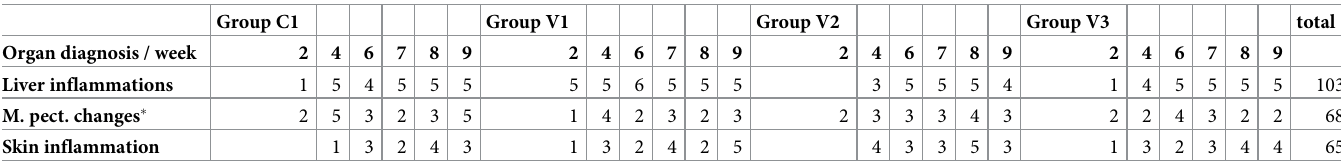
Table 4. Histopathological examinations for liver, M. pectoralis and skin per week and group (n). Group